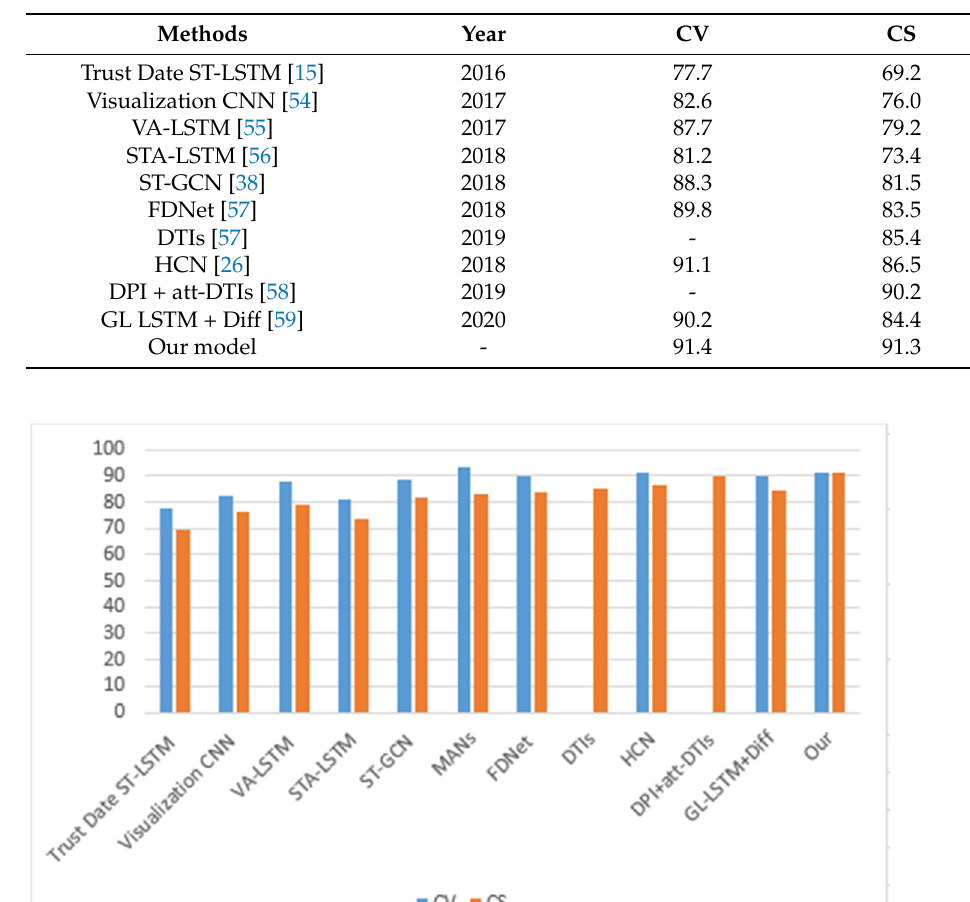
Figure 5. Accuracy comparisons for the cross-view (CV) and cross-subject (CS) evaluation for different models using the NTU RGB + D dataset .